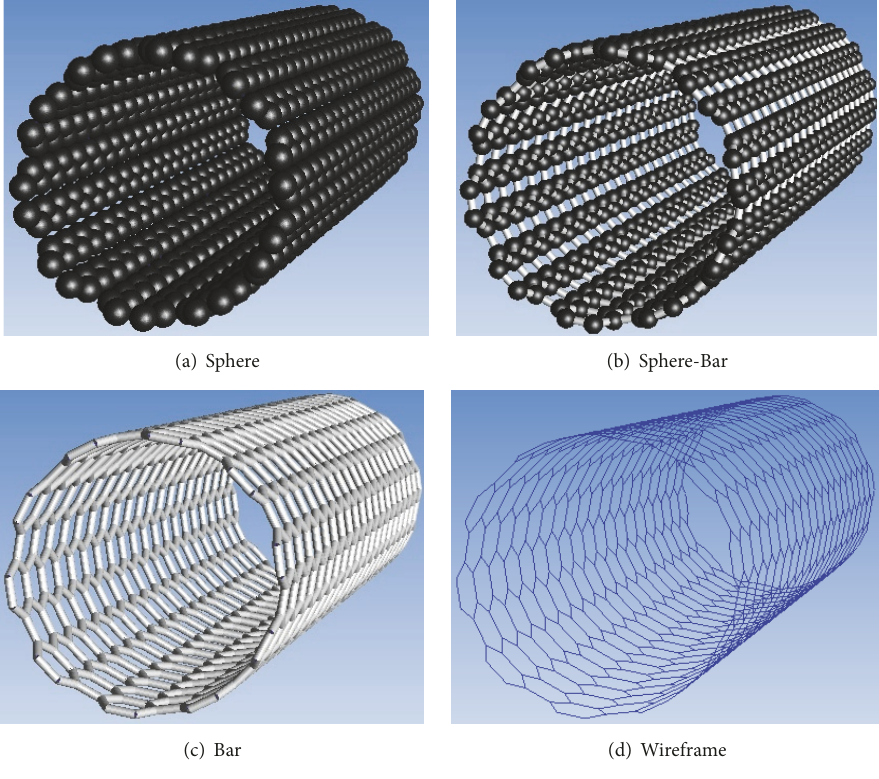
Figure 20: Multimode